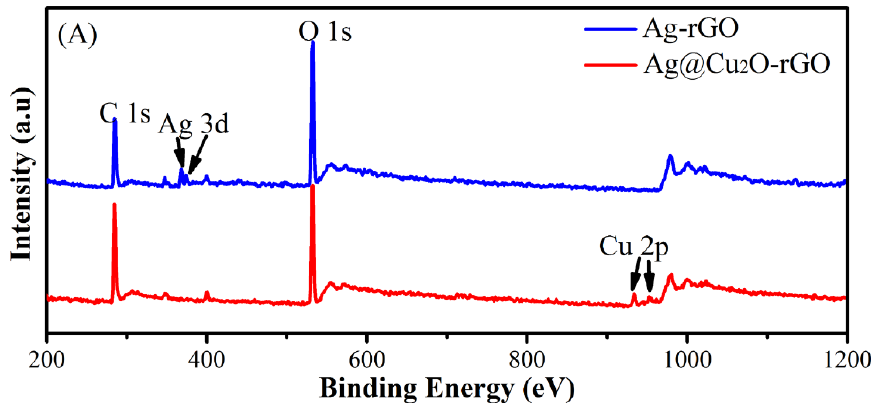
Figure 3. TEM image ( A ) and high-resolution TEM image ( B ) of the Ag@Cu 2 O-rGO (S-8 mM). The EDS line on the red segment in ( B ) corresponds to the different elements ( C ) and the corresponding element count-position curve ( D ).